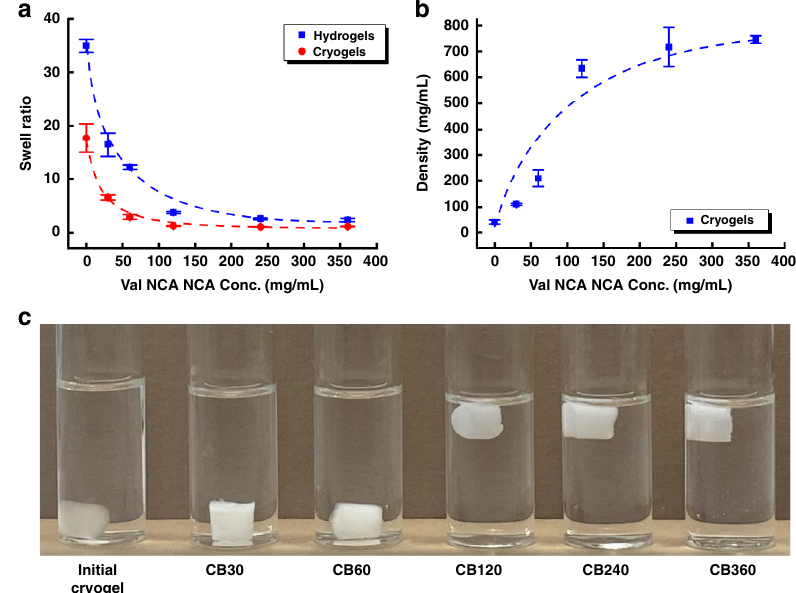
Fig. 2 Characteristics of networks in deionised water (glass vial diameter ~25 mm) at pH 6.7. a Equilibrium swell ratios of β -sheets-incorporated hydrogels and cryogels prepared with different Val NCA monomer concentrations (0~360 mg/mL); b Summary of bulk density of dry β -sheets- incorporated cryogels as a function of Val NCA concentrations (noting at higher than 120 mg/mL of Val NCA, the cryogels are non-swellable); c Photos showing the cryogels with different content of β -sheets. All error bars based on standard deviation ( n =